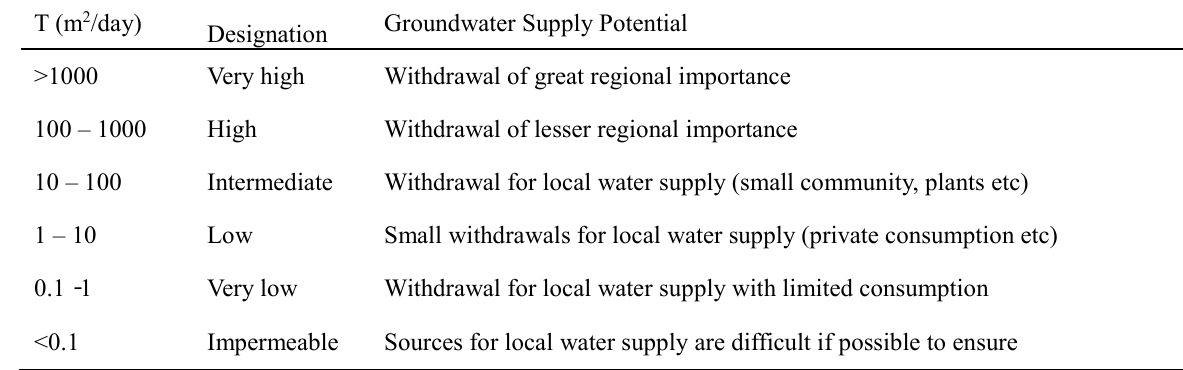
Standard for Transmissivity Classification